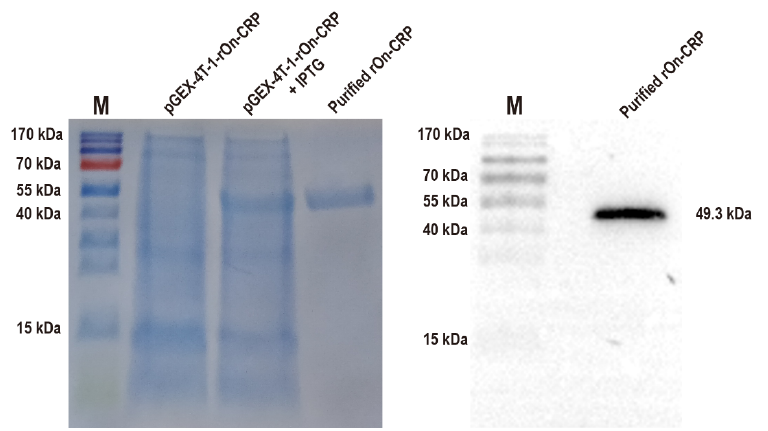
Figure 2. SDS-PAGE of the total proteins of the uninduced and induced bacterial strain contain prokaryotic recombinant vector pGEX-4T-1-rOn-CRP and the purified recombinant protein with the predicted molecular weight 49.3 kDa ( left ). Western blot of the purified rGST-On-CRP, detected via an anti-GST-tag antibody ( right ) The uncropped western blot figure was presented in Figure S1. After treatment with rGST-On-CRP (2 µM), the number of bacteria swallowed by MO/M Φ were significantly improved than that in blank group (PBS treated) or the negative control (2 µM GST-tag protein treated) (Figure 3A).